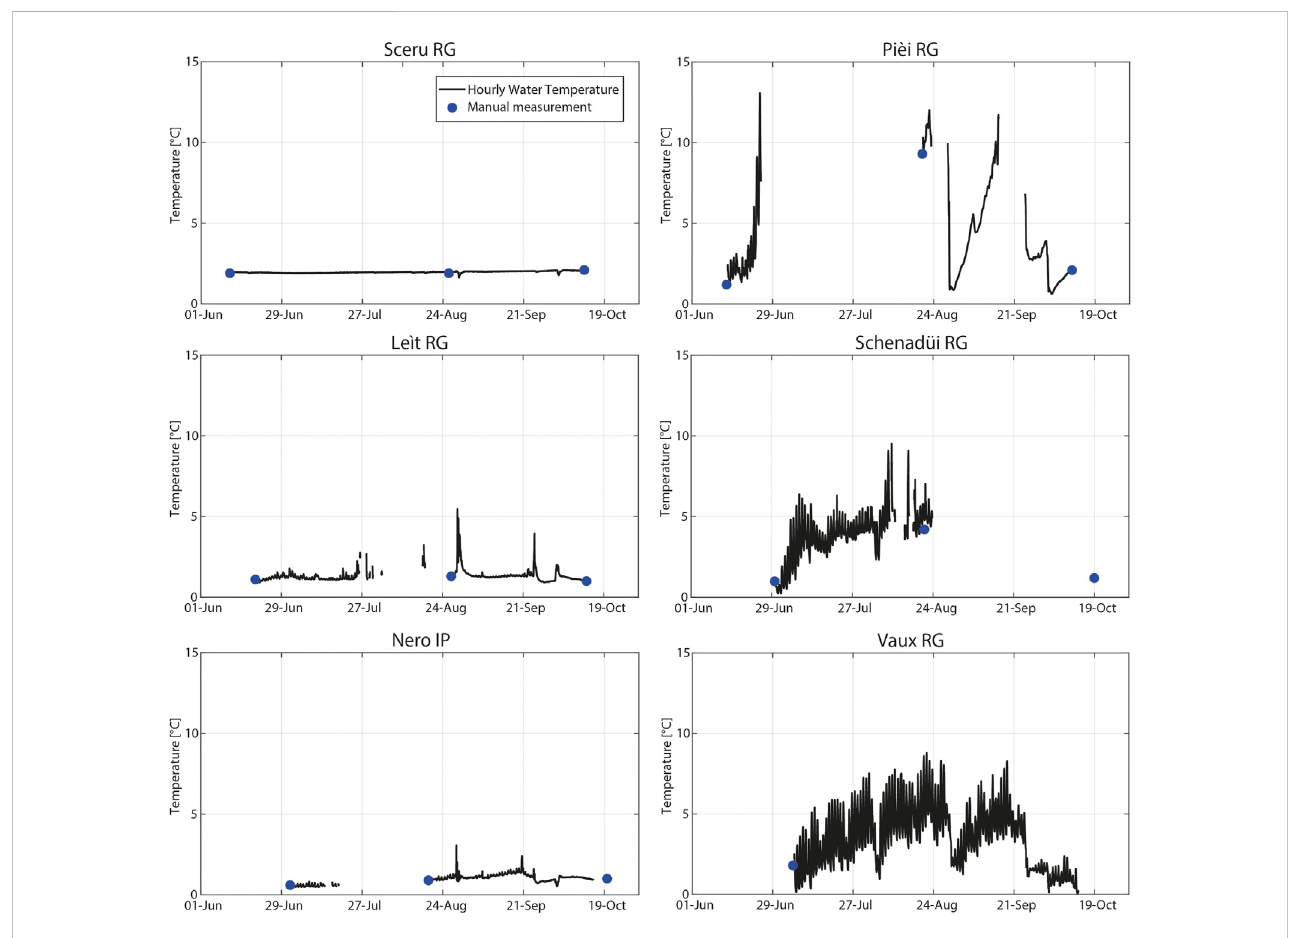
FIGURE 4 Hourly monitoring of the temperature in RG sources. Manual measurements of temperature through a digital temperature sensor are also